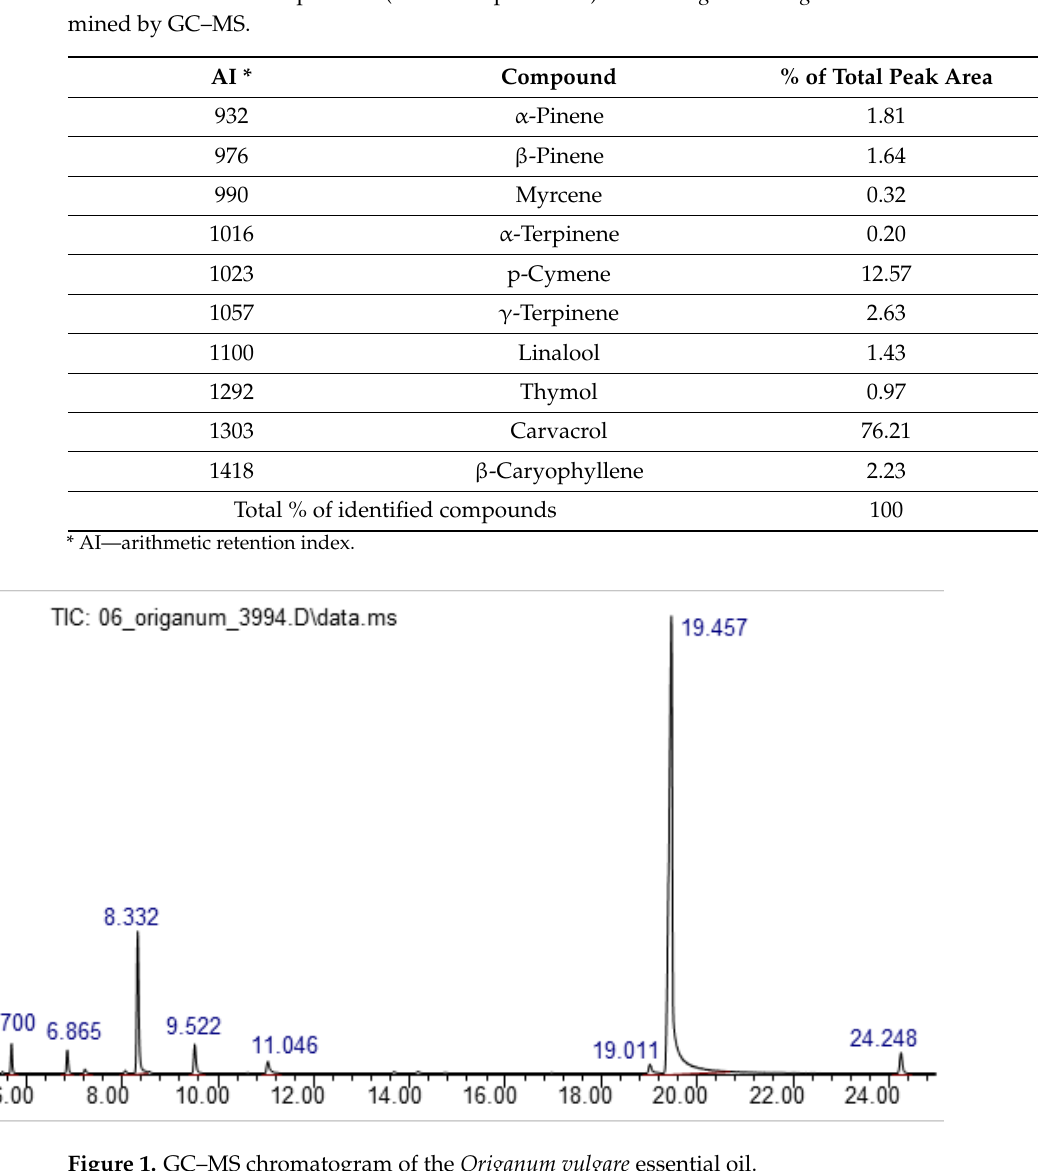
Figure 1 . GC–MS chromatogram of the Origanum vulgare essential oil . Figure 1. GC–MS chromatogram of the Origanum vulgare essential